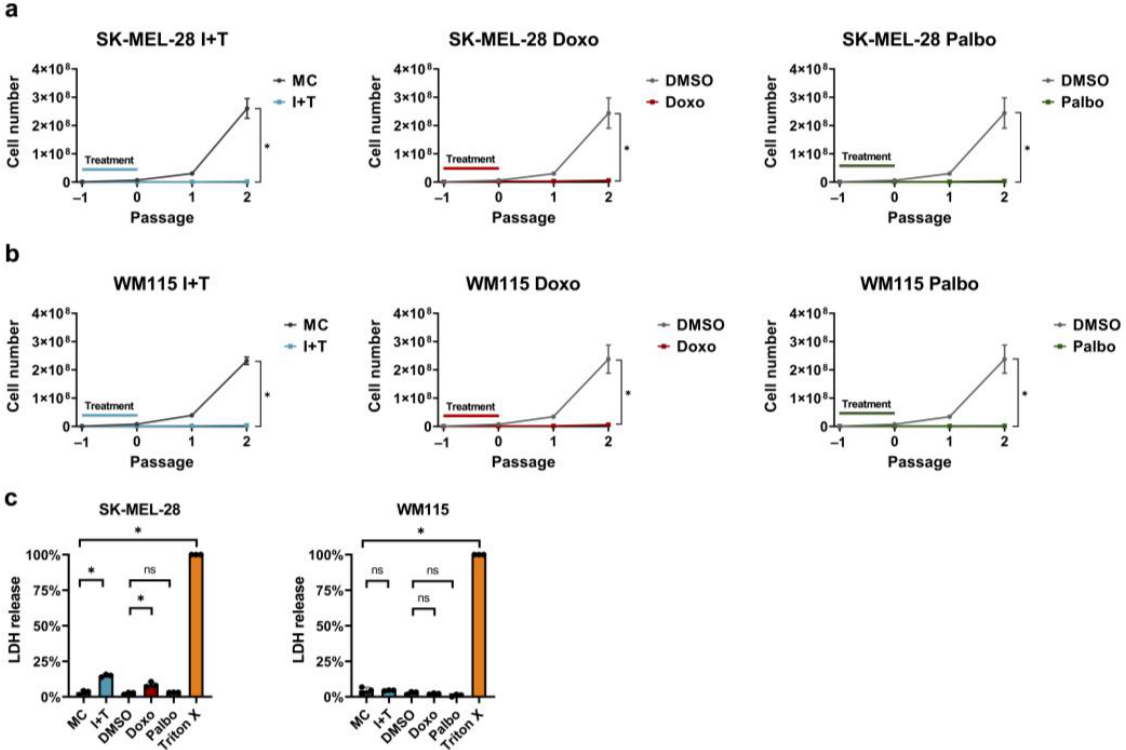
Figure 2. Treatment with IFN- γ and TNF, doxorubicin, and palbociclib induces a stable growth arrest and little to no LDH release. ( a , b ) Growth curves of SK-MEL-28 ( a ) and WM115 ( b ) melanoma cells treated with IFN- γ and TNF (I+T), doxorubicin (Doxo), and palbociclib (Palbo). MC, medium control. DMSO, vehicle control; same values for the DMSO control are shown in ( a , b ), as the same DMSO control was used for both treatments with Doxo and Palbo. The exact cell numbers for each condition are shown in Table 1. ( c ) Relative LDH release of each treatment was assessed for SK-MEL-28 (left panel) and WM115 (right panel) melanoma cells by the induced release of LDH after 96 h in relation to the maximum release of LDH for the respective condition. ( a – c ) Cell numbers and the results from the LDH release assay are from three independent experiments ( n = 3); unpaired Student’s t -test; mean ± s.d.; an asterisk (*) indicates a significant difference from the respective controls with p < 0.05. Table 1. Cell numbers (×10 6 ) that were counted and calculated in the growth arrest assay (Figure 2a,b) for each condition. The mean value (± s.d.) is indicated.